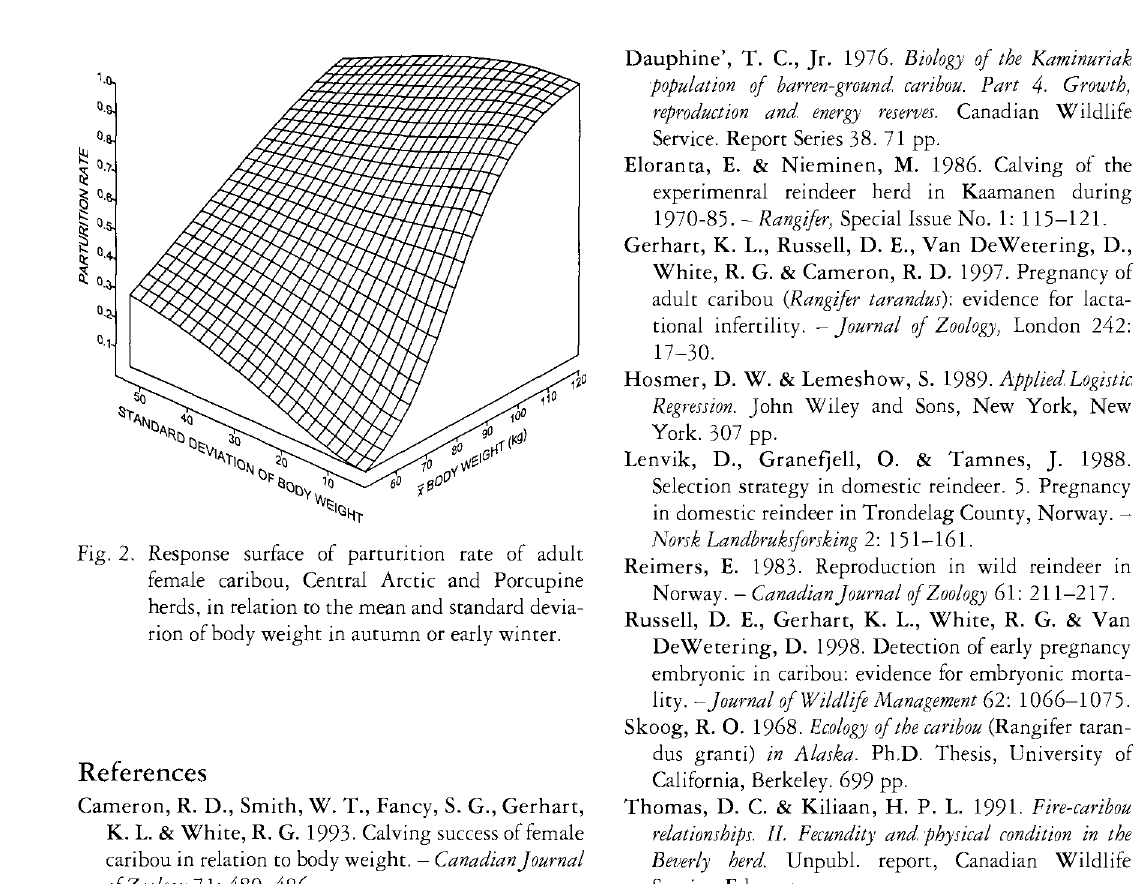
Fig. 2. Response surface of parturition rate of adult female caribou, Central Arctic and Porcupine herds, in relation to the mean and standard devia- rion of body weight in autumn or early